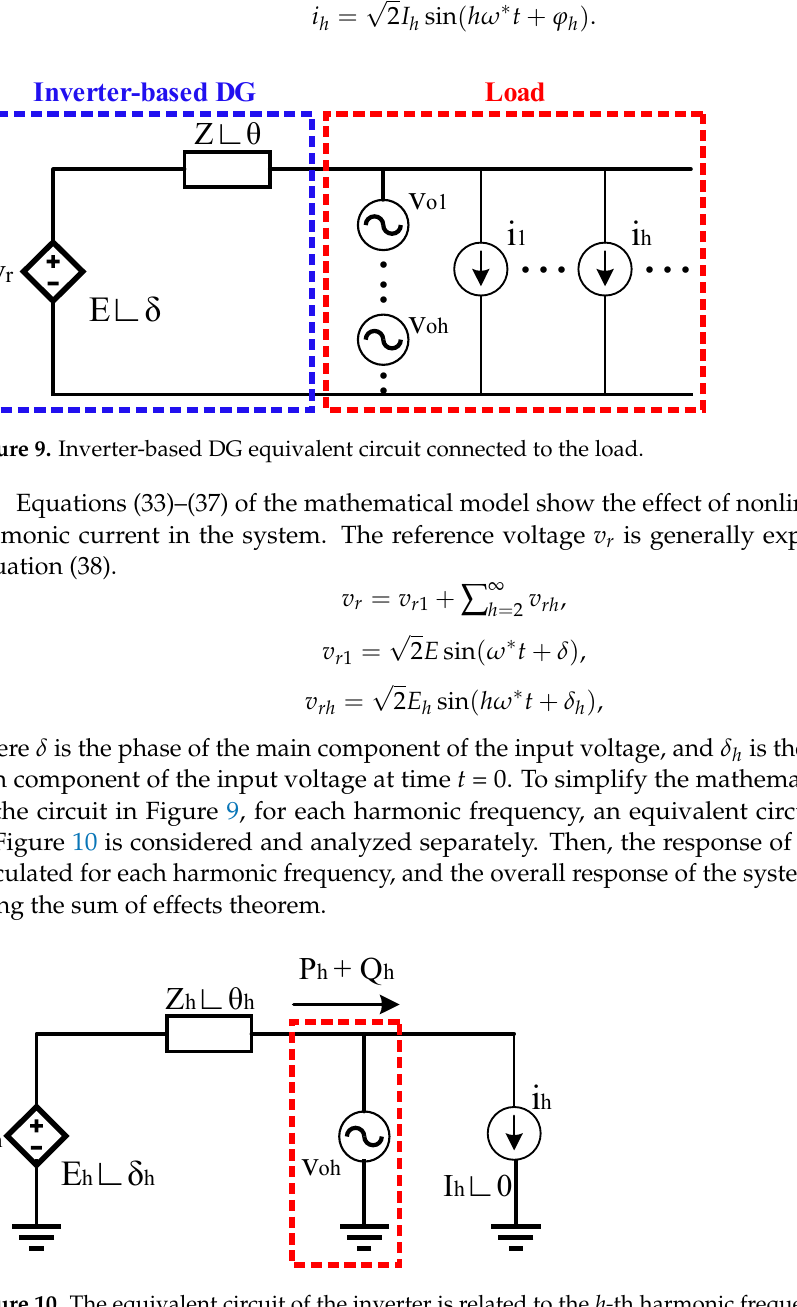
Figure 10. The equivalent circuit of the inverter is related to the h- th harmonic frequency.